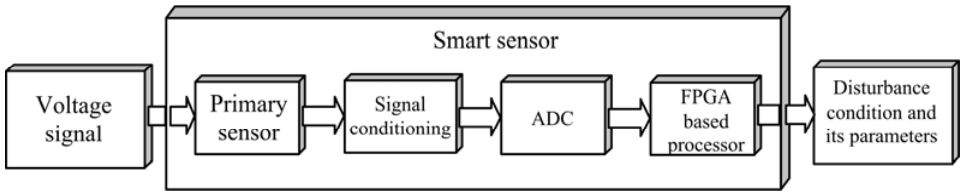
Figure 3. Block diagram of the PQD smart sensor.